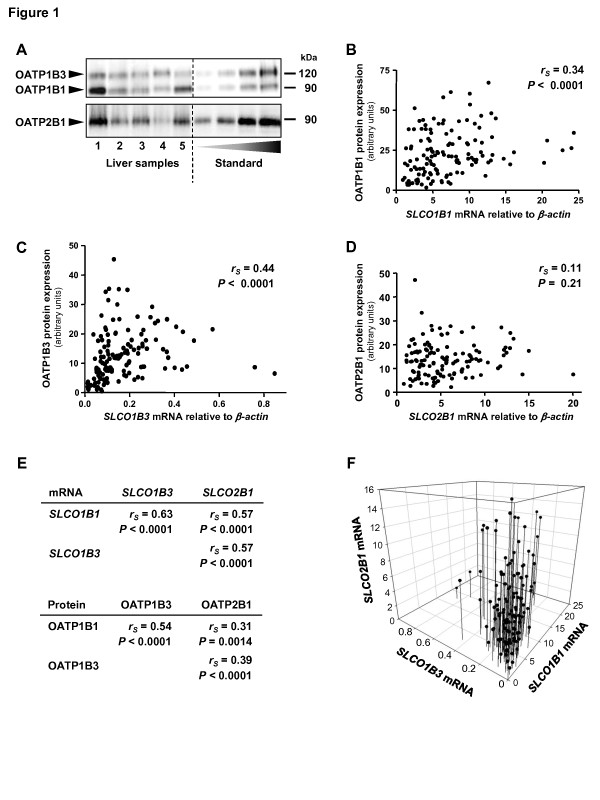
Hepatic expression of OATP1B1, OATP1B3 and OATP2B1 varies between individuals, but is coordinately regulated within one individual. (a) Representative immunoblot of liver membrane fractions (20 μg) quantified relative to a standard liver sample. (b-d) Correlation analyses of OATP protein and SLCO mRNA levels in human liver samples. (e, f) Correlation analyses of all three OATPs showed a coordinated expression of SLCO1B1, SLCO1B3, and SLCO2B1 mRNA and OATP1B1, OATP1B3, and OATP2B1 protein levels in the non-cholestatic liver sample set. rS, Spearman rank-order correlation coefficient.